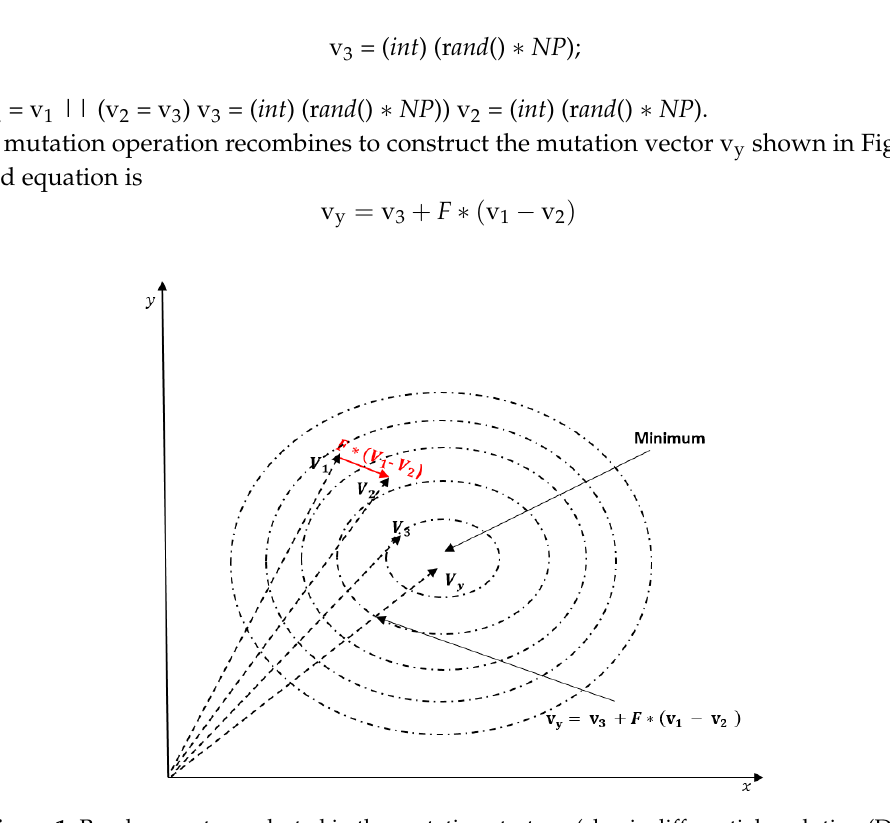
Figure 1. Random vectors selected in the mutation strategy (classic differential evolution (DE)).